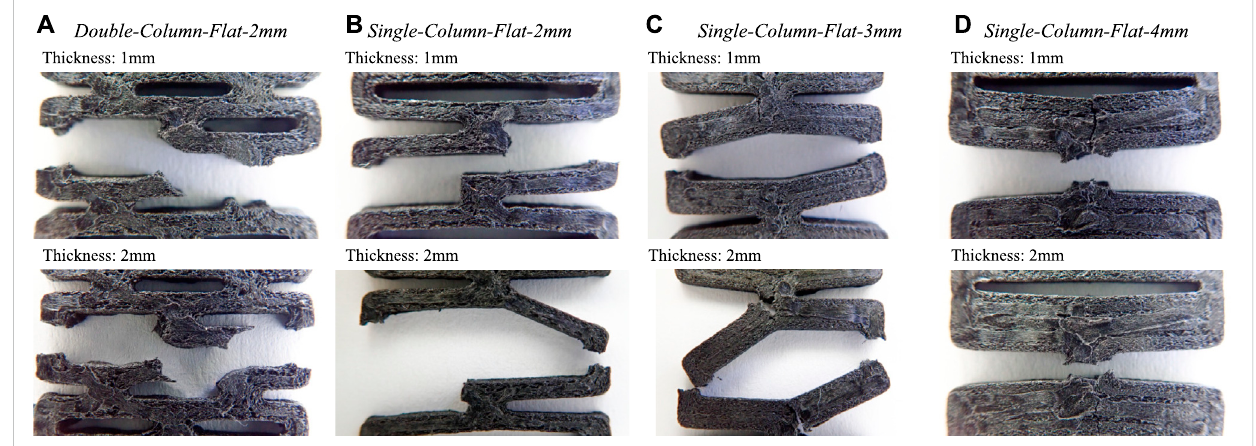
FIGURE 9 Close-up photos of cracked kirigami-inspired springs in tensile test with different patterns and thicknesses. (A) Double-Column-Flat-2mm pattern; (B) Single-Column-Flat-2mm pattern; (C) Single-Column-Flat-3mm pattern; (D) Single-Column-Flat-4mm pattern.